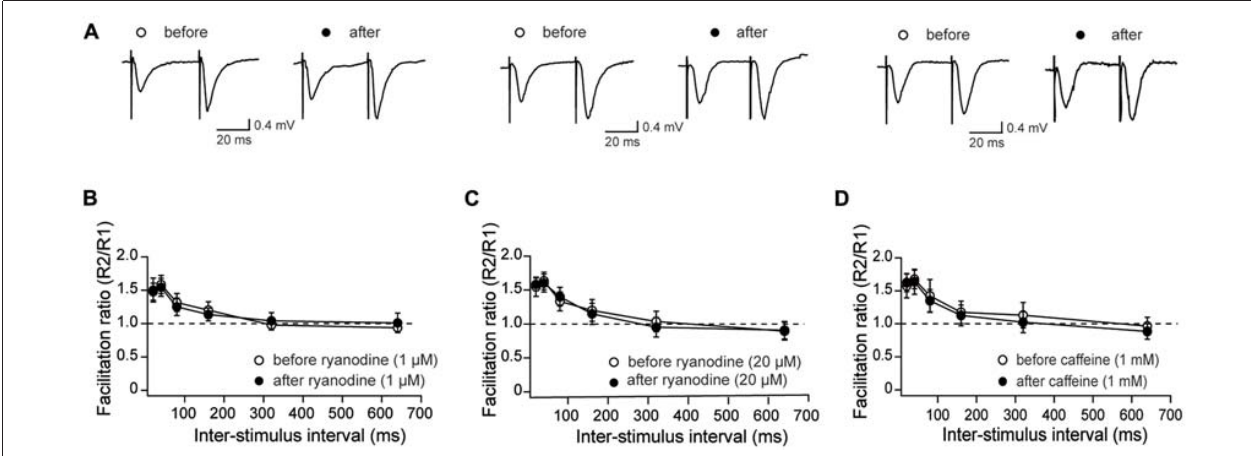
FIGURE 3 | Effects of stimulatory and inhibitory ryanodine concentrations and of caffeine on paired-pulse (PP) responses measured in CA3–CA1 hippocampal synapses. (A) Representative fEPSP traces showing PP responses before and after addition of 1 µ M ryanodine (left panels), 20 µ M ryanodine (center panels) and 1 mM caffeine (right panels). (B) Effects of 1 µ M ryanodine applied for 15 min on PP facilitation. The graph illustrates the facilitation ratio vs. inter-stimulus intervals. (D) Effects of 1 mM caffeine applied for 15 min on PP facilitation. The graph illustrates the facilitation ratio vs. inter-stimulus intervals. (C) Effects of 20 µ M ryanodine applied for 60 min on PP facilitation. The graph illustrates the facilitation ratio vs. inter-stimulus intervals. Values represent Mean ± SE; (13, 4) for ryanodine-treated slices; (12, 3) for caffeine-treated slices and (16, 4) for the control. The first number in parentheses indicates the number of hippocampal slices and the second the number of animals